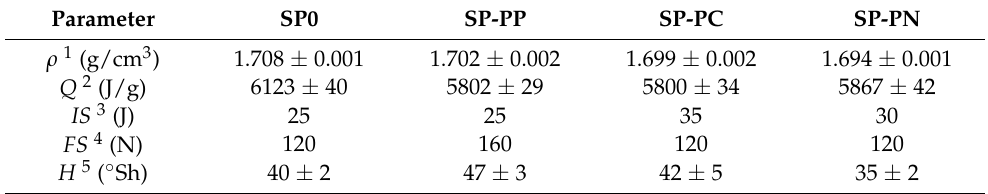
Table 4. Physicochemical properties and sensitivity to mechanical stimuli of obtained propellants.